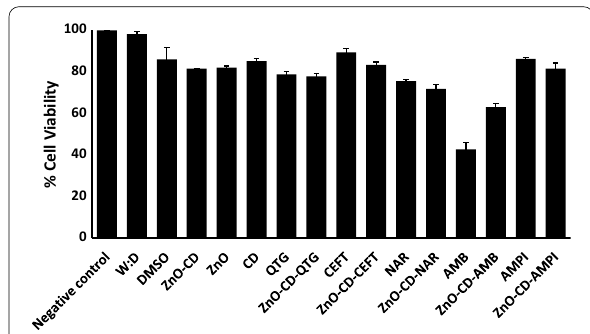
Fig. 8 Treatment with ZnO-NPs and drug conjugates exhibited minimal cytotoxicity against human cell lines. Human cells were grown in 96 well plate up to 80–90% confluency as discussed in material and methods. Next, cells monolayer was challenged with drugs-NPs combinations for 24 h at 37 °C in humidified conditions with 5% CO 2 . Cells alone in RPMI was taken as negative control. The data are representative of several experiments performed in duplicate and expressed as the mean standard error, where (*) represent ± when P 0.05. Data was analyzed using Graph Pad Prism software ≤